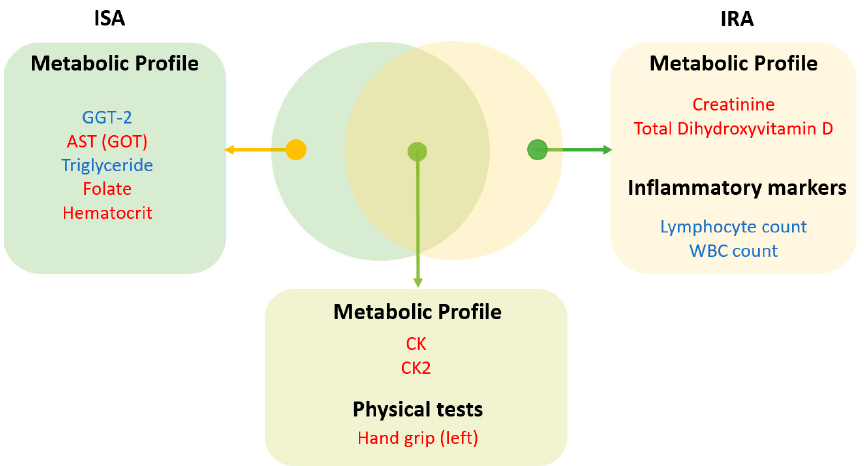
# This analysis incorporated the interaction between HOMA-IR category and physical activity groups, the estimate represents the offset in the intercept from the active individuals to sedentary baseline. SE: standard error; FDR: false discovery rate.